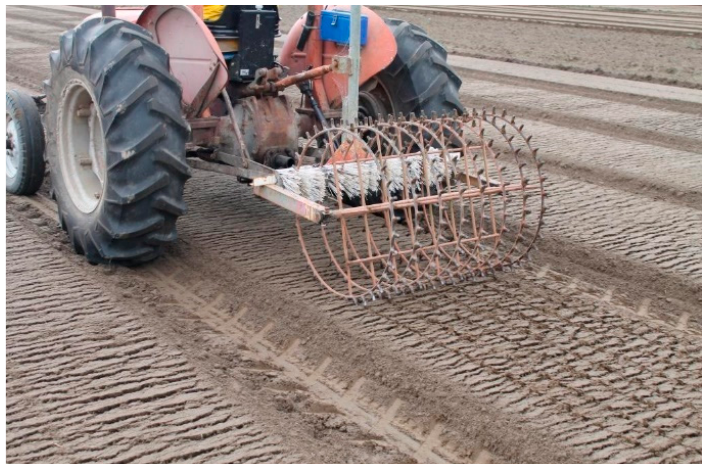
Figure 4. A tractor-pulled dibbler with a set of spiked wheels.